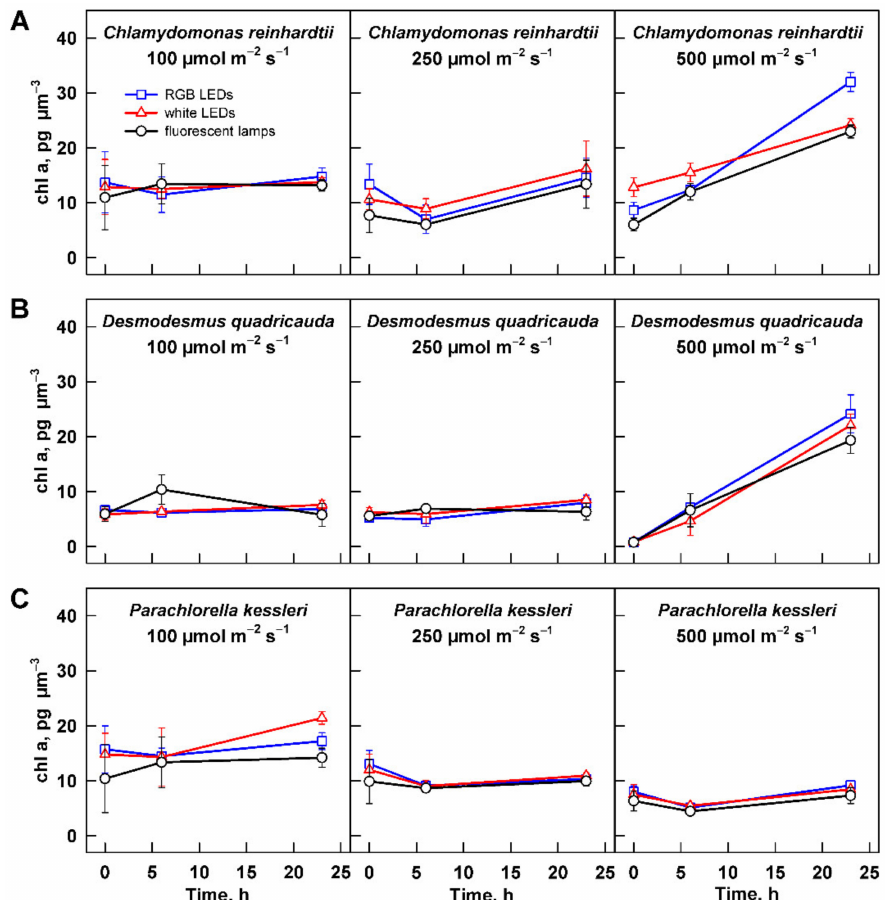
Figure 7. Changes in chlorophyll a content in the cultures grown at different light intensities. Cul- tures of ( A ) Chlamydomonas reinhardtii , ( B ) Desmodesmus quadricauda , and ( C ) Parachlorella kessleri were grown at incident light intensity 100, 250, and 500 µ mol m − 2 s − 1 on different light sources: fluores- cent lamps (black circles), RGB LEDs (blue squares), and white LEDs (red triangles). Chlorophyll content was normalized to the total volume of the culture at the particular time point to allow direct comparison between treatments and organisms. Data of three biological replicates are presented as means ±